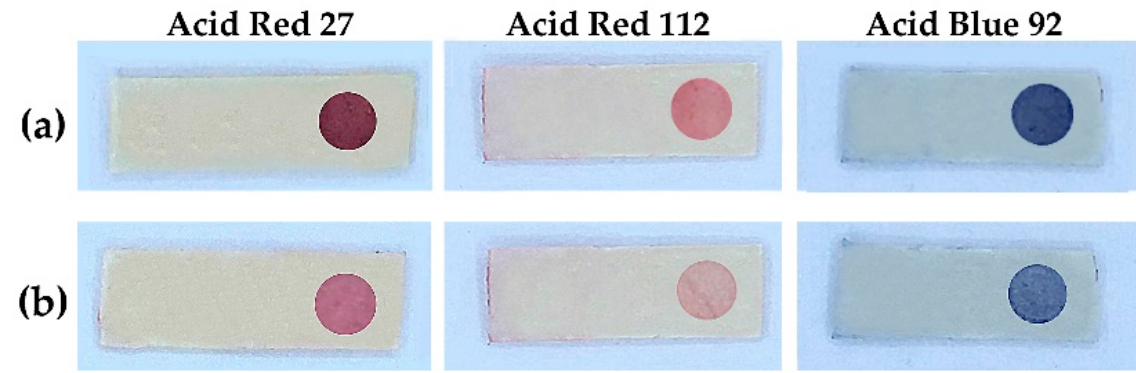
Figure 1. Sensor platform: ( a ) immobilized with anionic dyes; and ( b ) after treatment with 100 mM FA. (Sensor platform size: 0.1 × 0.5 × 2.0 cm).